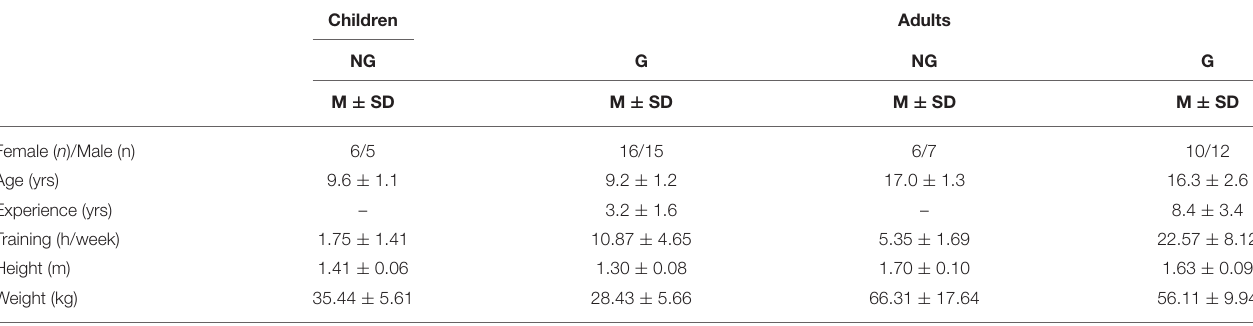
TABLE 1 | Participants general characteristics.